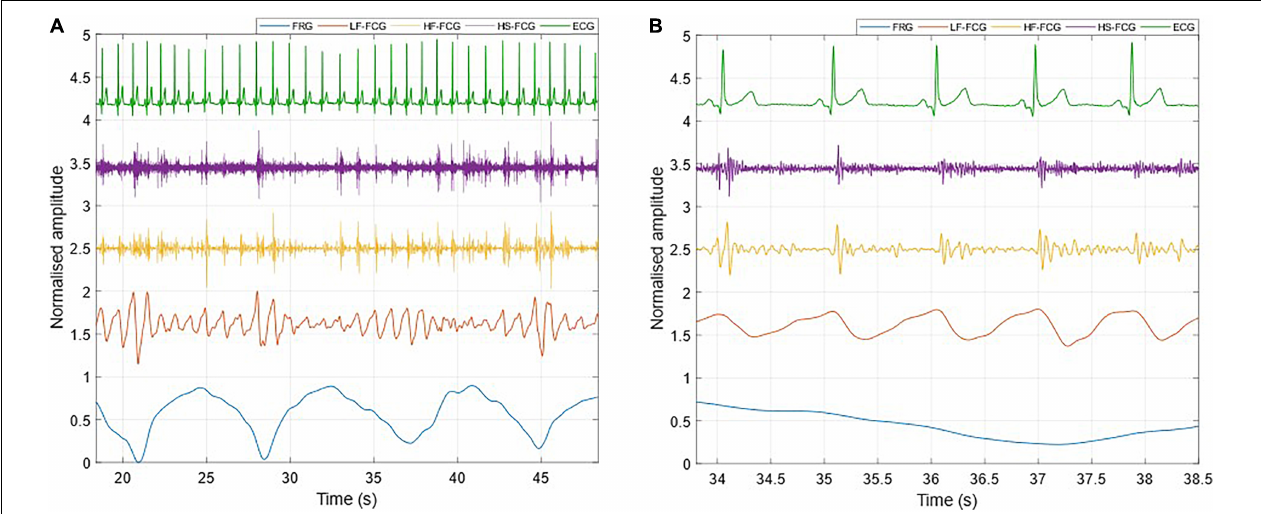
FIGURE 5 | All components extracted from the FCG signal acquired by the FSR-based sensor. (A) 30-s excerpt from subject #2; (B) 5-beats excerpt from (A) .